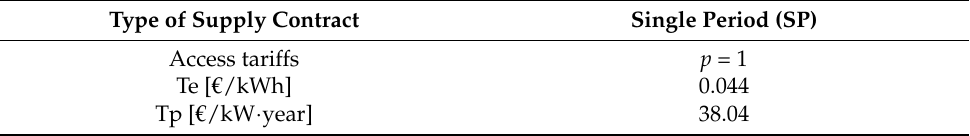
Table 1. Access tariff coefficients. Source: self-elaboration based on [39].